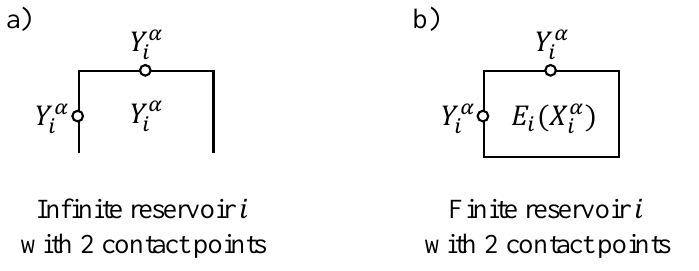
Figure 1. Schematics of reservoirs illustrated here with two contact